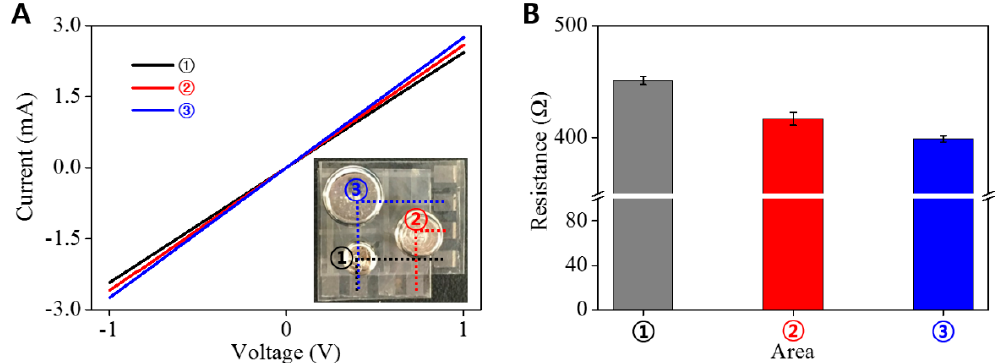
Figure 7. ( A ) The I-V curve and ( B ) resistance of a sandwich-type pressure-sensor device for demonstrating the functionality of the sensor array. (A inset) Photograph of sensor array with AgNW-PEG line patterns (width: 1 mm) on PET substrate under several weight pressures ( ① 2 g; ② 5 g; ③ 10 g).